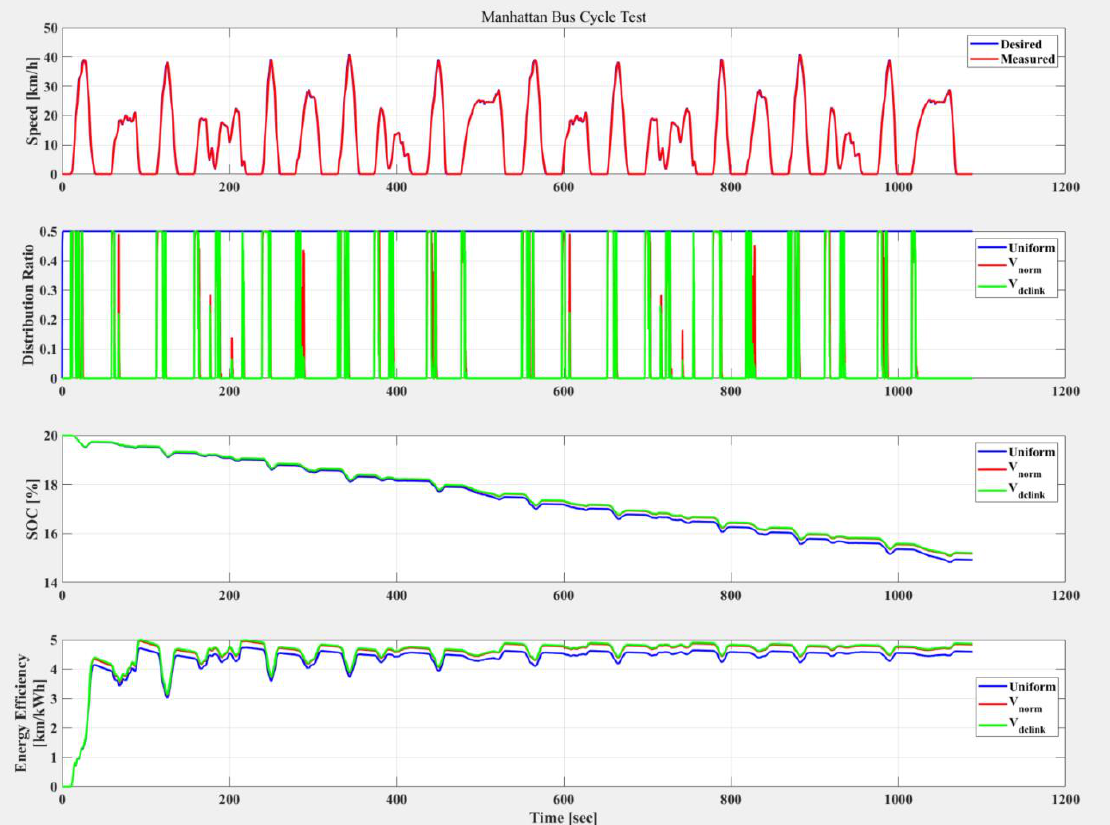
Figure 16. Simulation results.